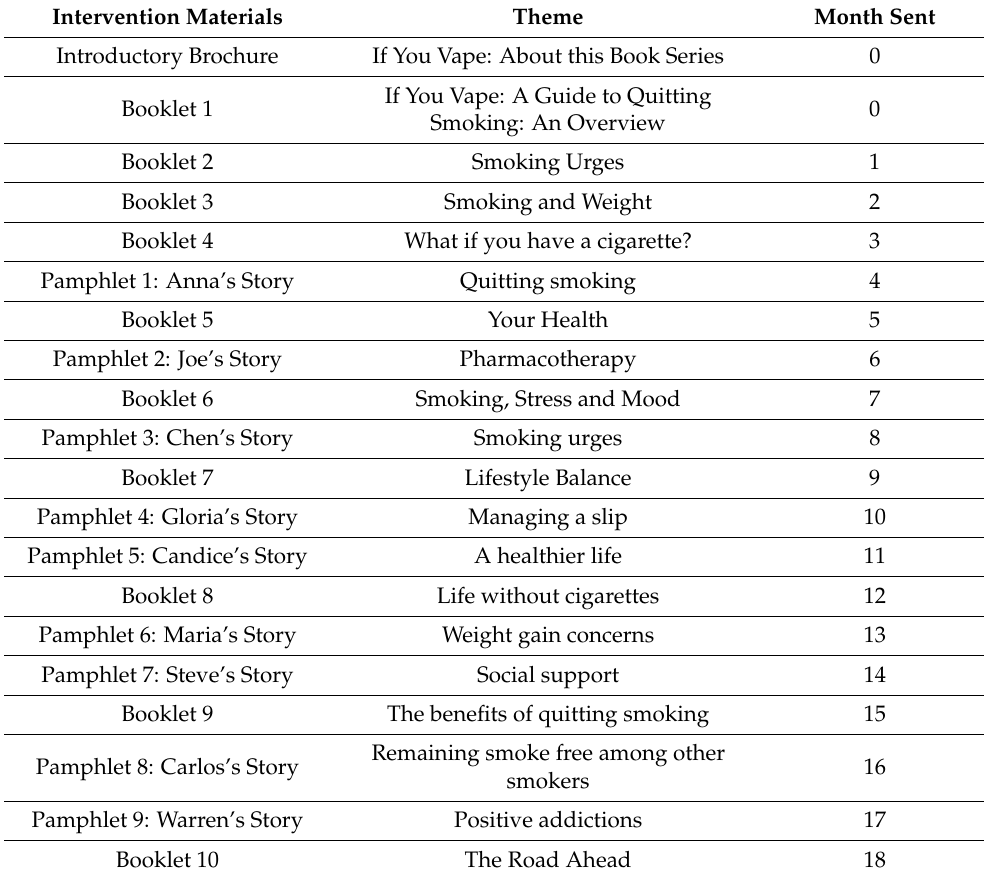
Table 3. Final intervention booklets and pamphlets: titles, themes, and distribution